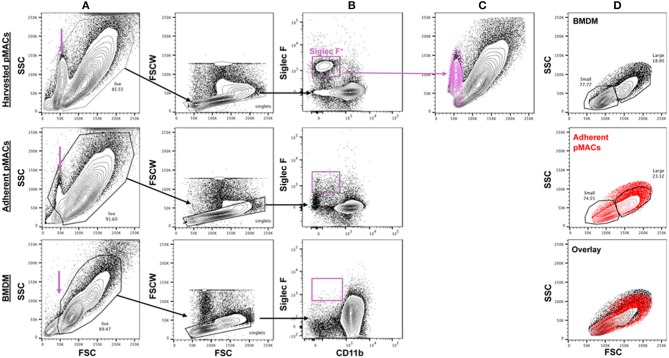
The size and granularity of bone marrow-derived and peritoneal macrophages are similar, but not identical. (A) Harvested peritoneal cells contain a population of small, moderately granular cells (purple arrow) that are reduced upon adhesion and not found in preparations of BMDMs. (B,C) Harvested peritoneal cells have a minor (11 ± 4.4%) population of Siglec F+ cells that is substantively removed upon adhesion (2.1 ± 1.1% post-adhesion) that co-localizes with the small, granular population. (D) BMDMs and adherent pMACs are similar with respect to size (FSC) and granularity (SSC). Representative of 10 preparations each of bone marrow and peritoneal macrophages.